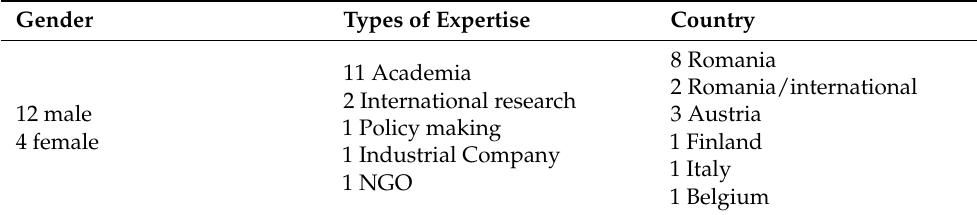
Table 1. Profile of workshop participants. Gender Types of Expertise